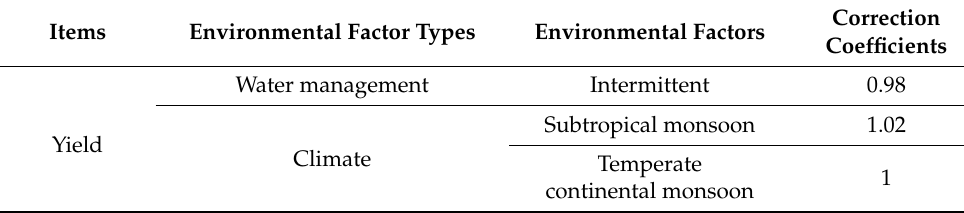
Table 6. Environmental correction